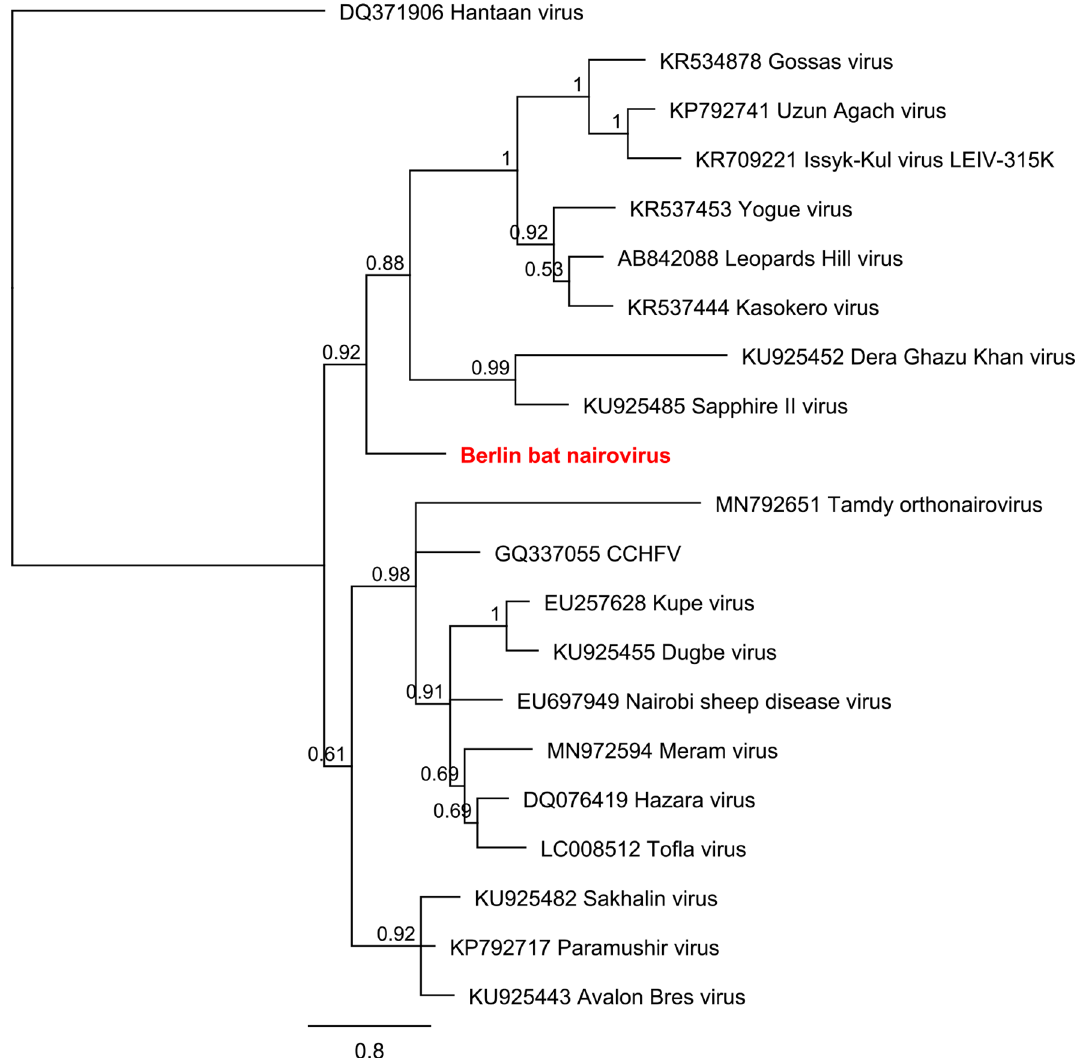
Figure 5. Phylogenetic reconstructions of Nairoviruses—2 ML, 1 million, 457 nt of the L segment. Reconstruction was performed via the Bayesian MCMC approach using MrBayes with the following settings (burn-in, 30%; frequency, 100; chain length, 1 million to 10 million, depending on when a standard derivation of below 0.025 was reached) 78 . Hantaan virus was used as an outgroup. Reconstructed trees were visualized using FigTree and posterior probabilities were depicted for each node (http:// tree. bio. ed. ac. uk/ softw are/ figtr